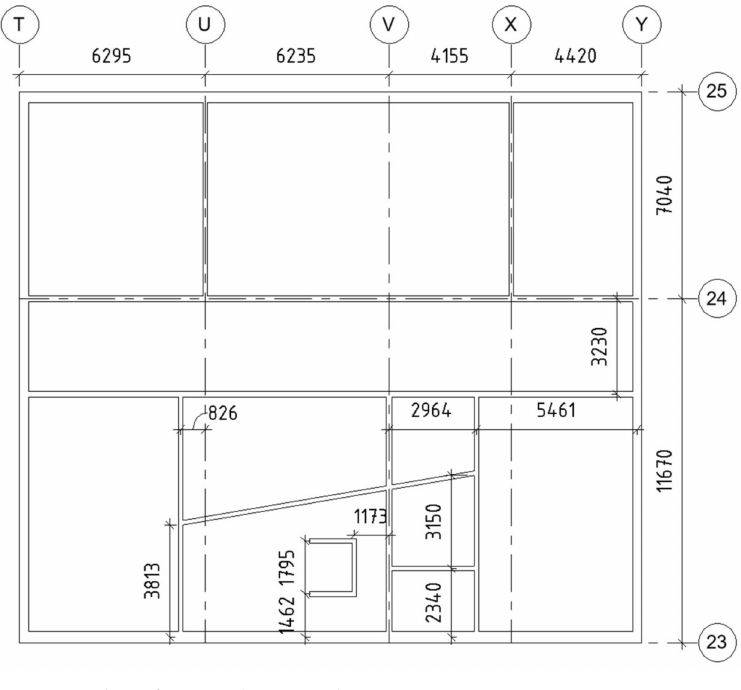
Figure 3. Plan of story 1 (unit: mm).